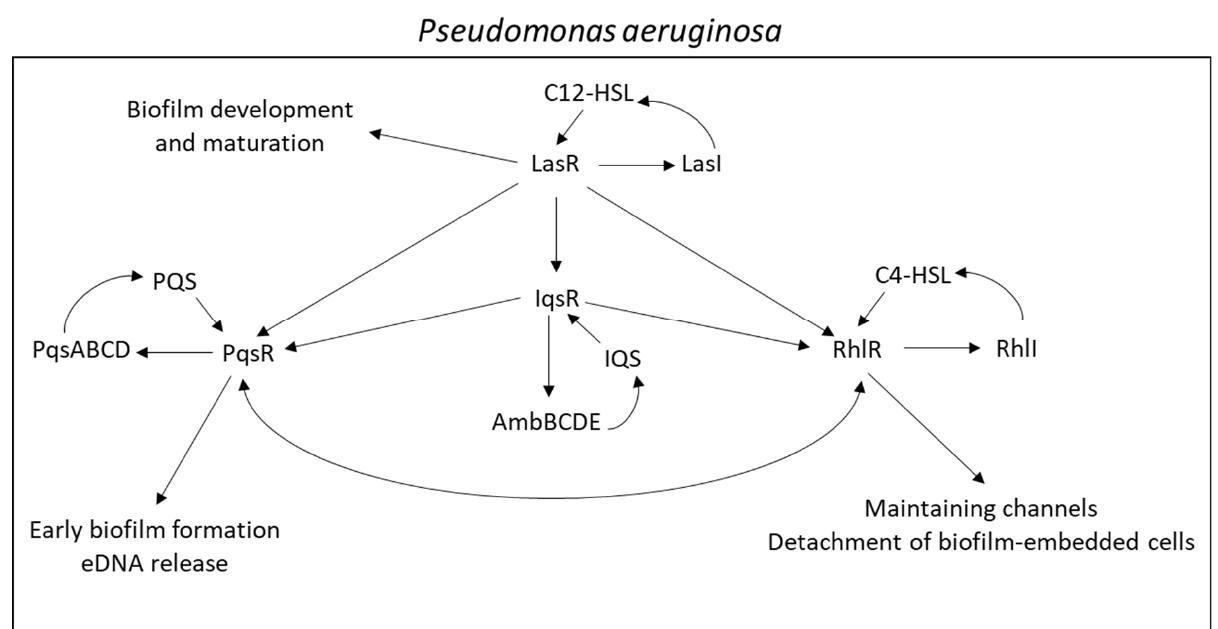
Figure 8. Crosstalk of the four QS systems Las, Rhl, Pqs, and Iqs in Pseudomonas aeruginosa and their relationship to biofilm formation . Each of the four TCS systems produces its own autoinducer (C12-HSL, PQS, IqsR, or C4-HSL) that acts on the corresponding receptor (LasR, PqsR, IqsR, or RhlR). The receptors, in turn, elicit phosphorelay cascades resulting in altered expression of a large number of genes. In addition, there is crosstalk between these TCSs. LasR affects PqsR, IqsR, and RhlR. There is also mutual communication between PqsR and RhlR. LasR is involved in biofilm development and maturation. PqsR is involved in early biofilm formation and the release of extracellular DNA. RhlR is involved in the maintenance of biofilm channels and the detachment of biofilm-embedded cells. IqsR promotes biofilm formation by acting on PqsR and RhlR.